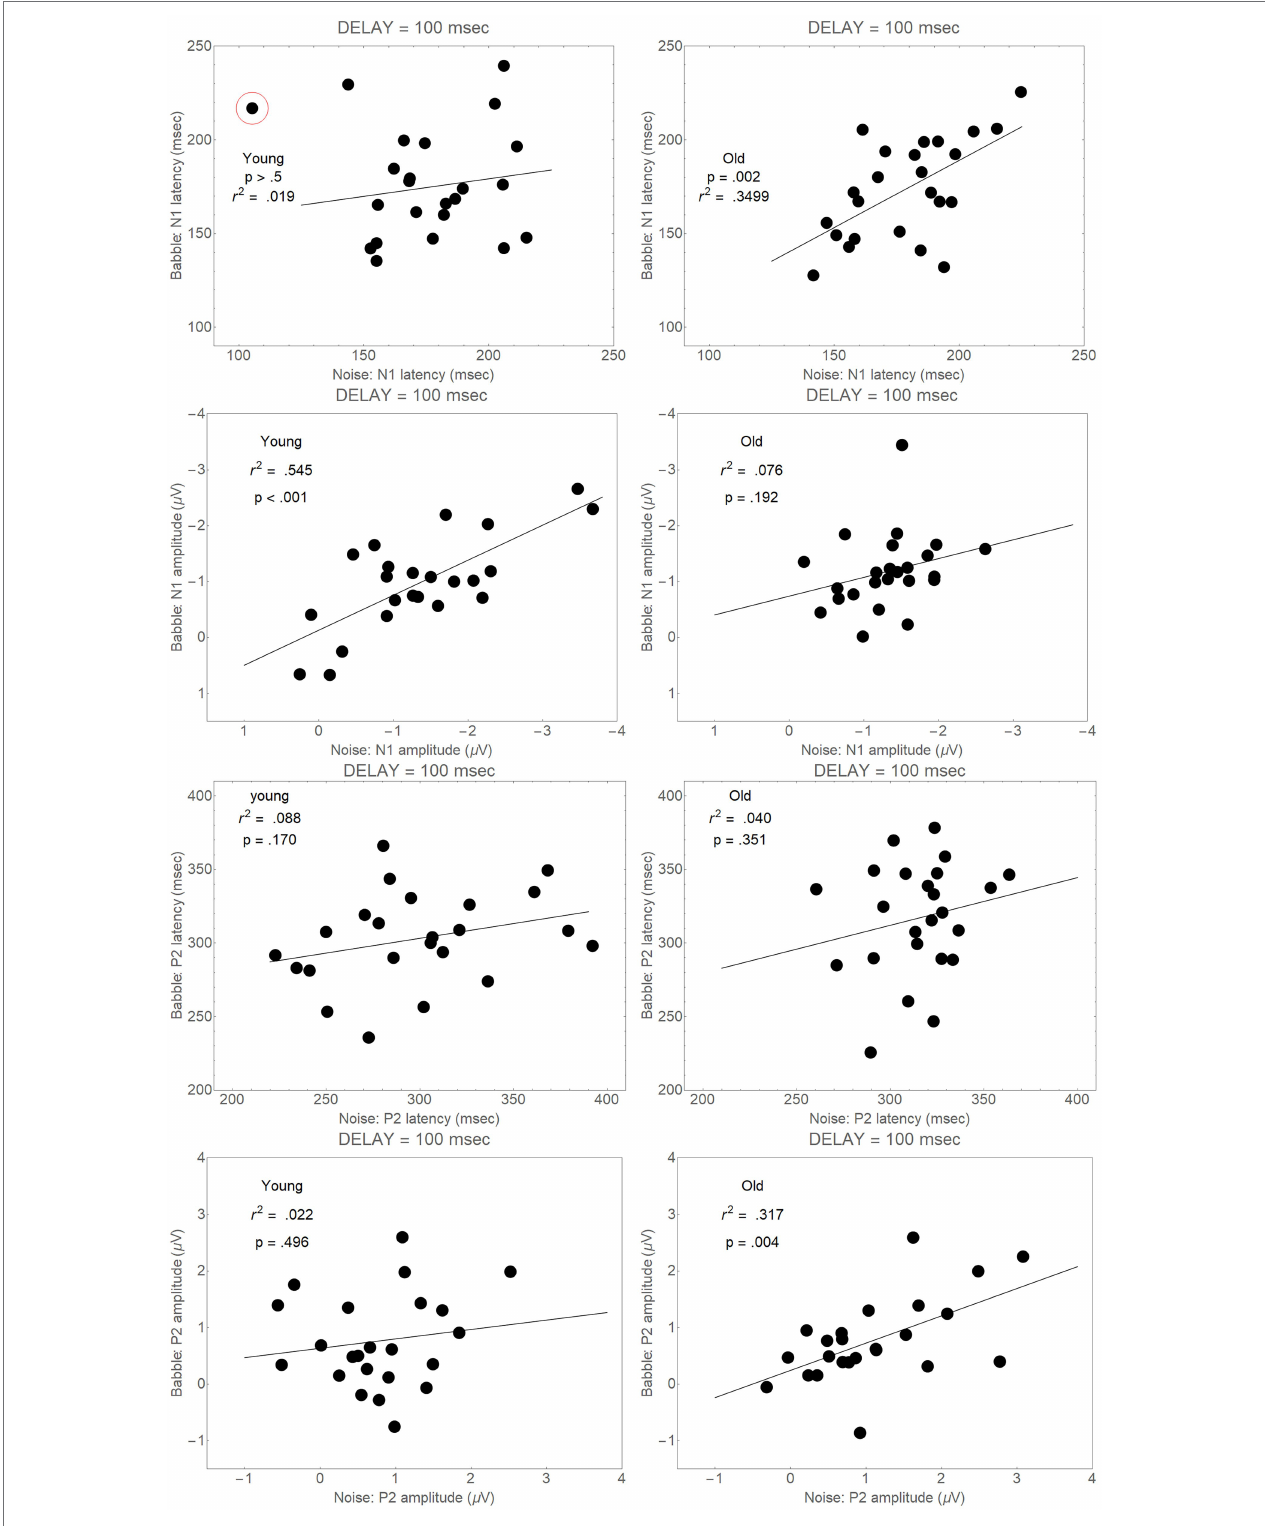
FIGURE 7 | Correlations between Noise and Babble latencies and between Noise and Babble peaks for Onset Delay = 100 ms for both N1 and P2 peaks. The circled point in the top left-hand panel was not included when the correlations were conducted because it was too close to the lower boundary for latency and the upper boundary for